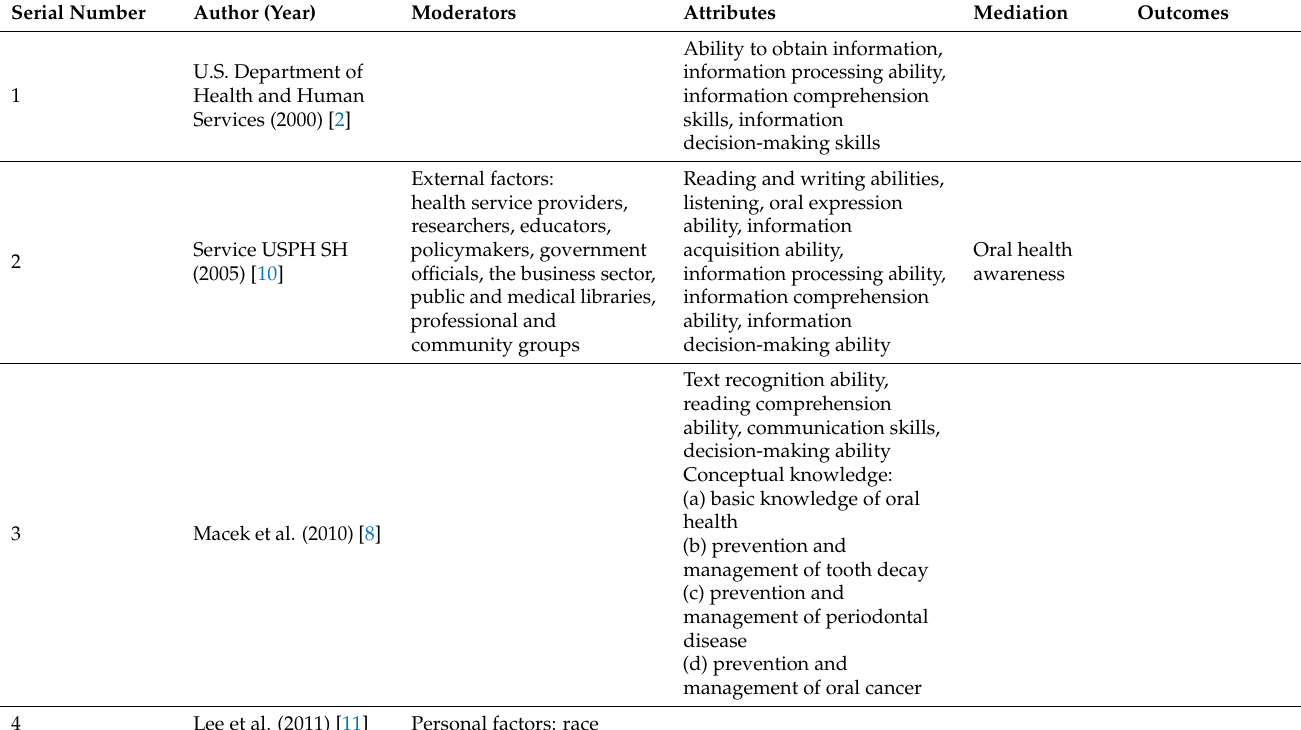
Table 3. OHL conceptual model information